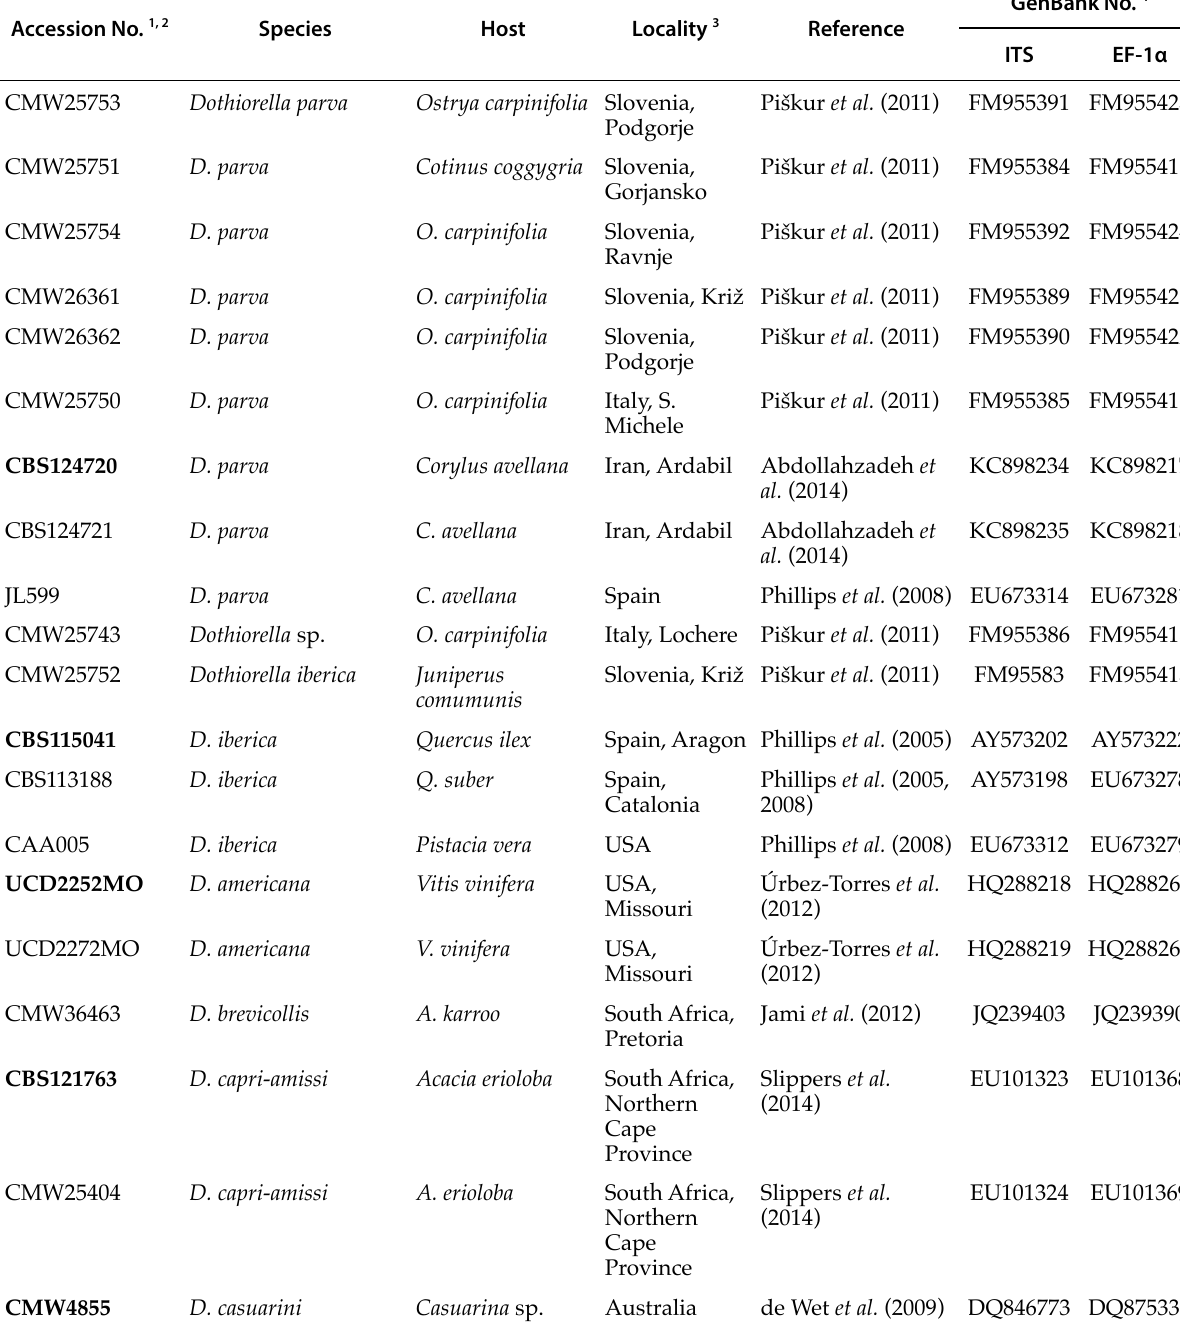
Table 1. Isolates included in the phylogenetic